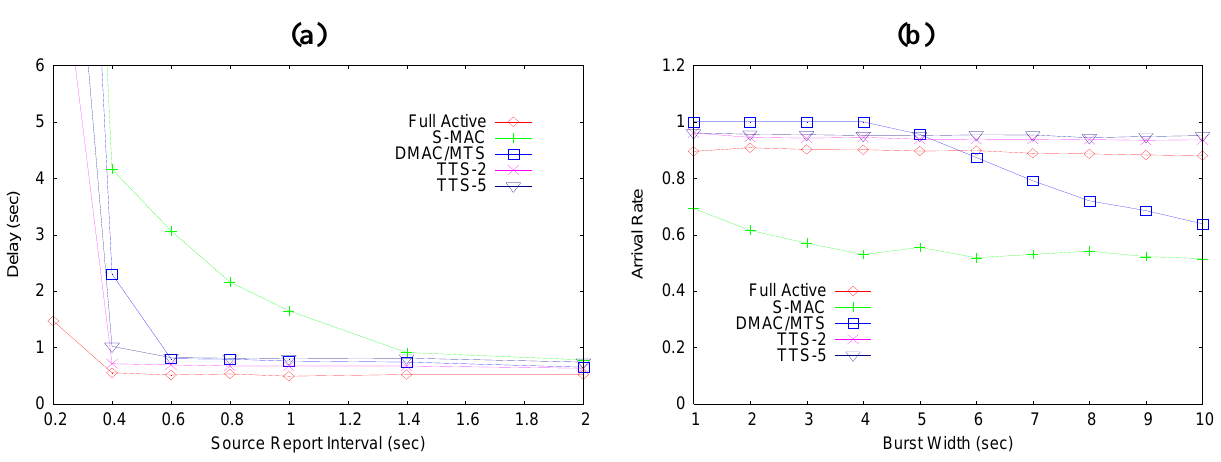
Figure 8. (a) Delay characteristics with source report interval. (b) Data arrival rate with burst